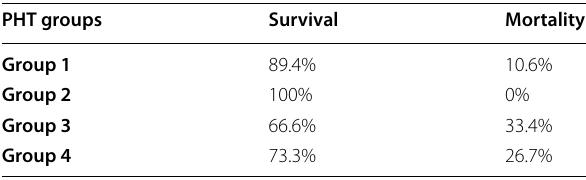
Table 4 Survival rate in 1-year